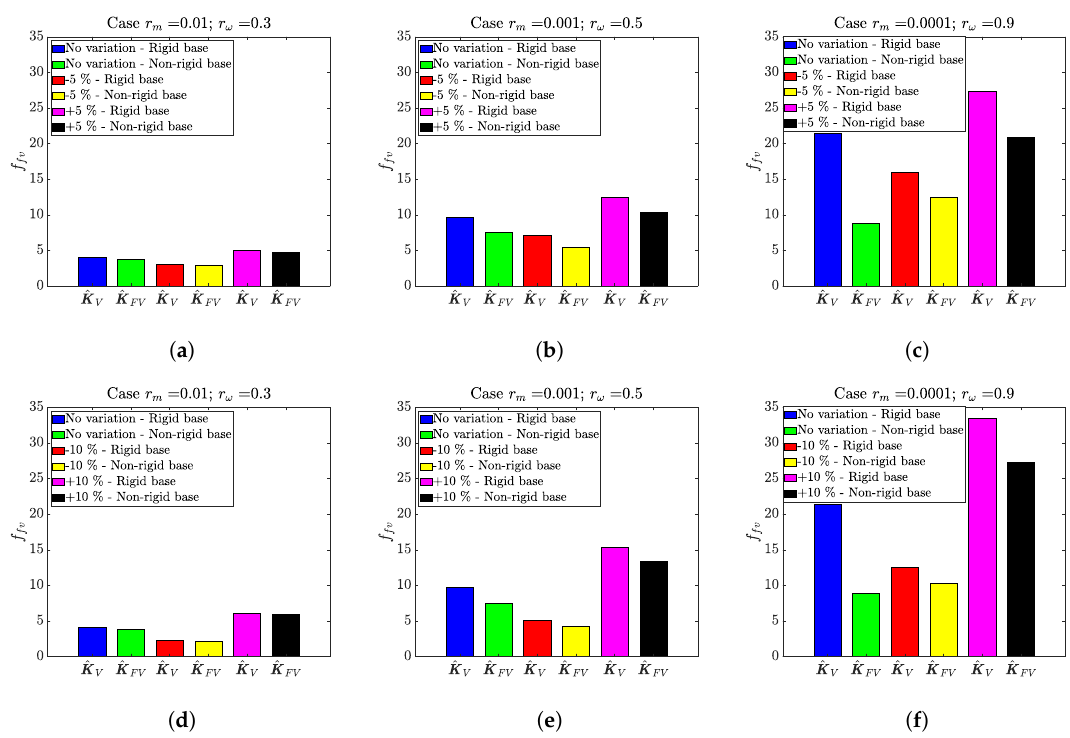
Figure 12. Effect on the VI and alignment performance of 5% variation ( a – c ) and 10% variation ( d – f ) in the dynamic parameters ζ p , ω p of the mid-span isolator—non-symmetrical 2 2